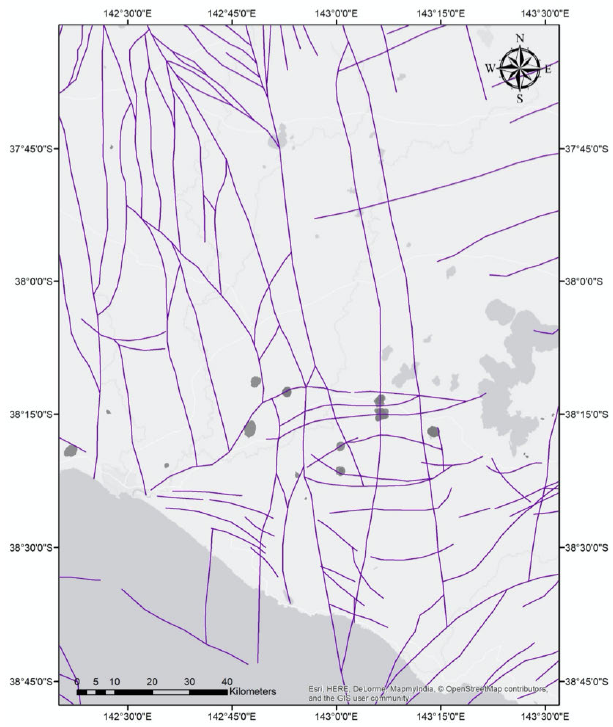
Figure 12: Faulting along the western side of the Newer Volcanic Province (Australia). Several maars are inter- sected by faults but do not have primary elongation ori- entations that match the fault. Data from Boyce